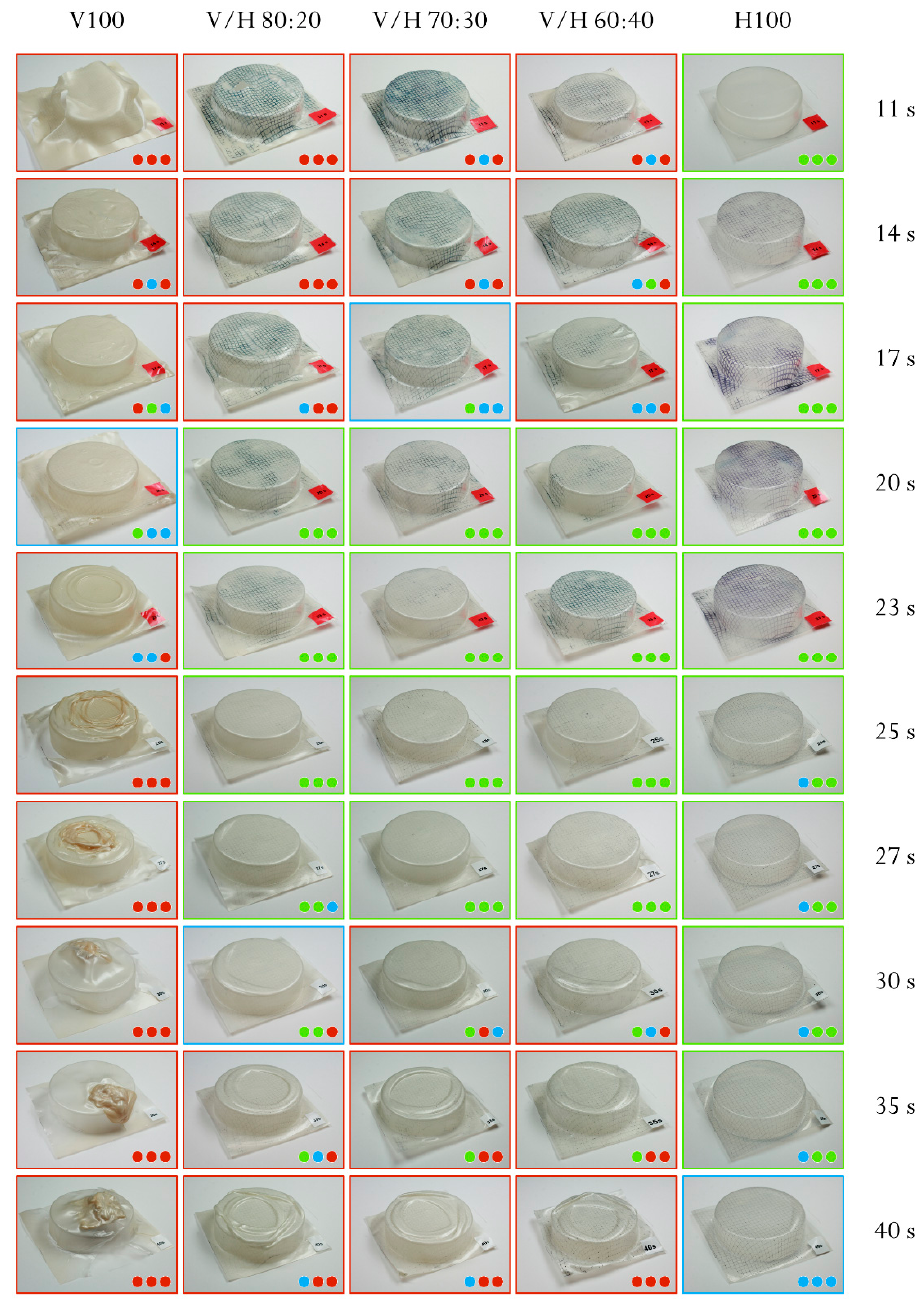
Figure 11. Photographs and evaluation of the thermoformed structures of poly(3-hydroxybutyrate- co -3-valerate) (PHBV), poly(3-hydroxybutyrate- co -3-hydroxyhexanoate) (PHBH), and their blends depending on the processing time. Each image is accompanied by three assessing symbols in order of edge–corner thickness from left to right.